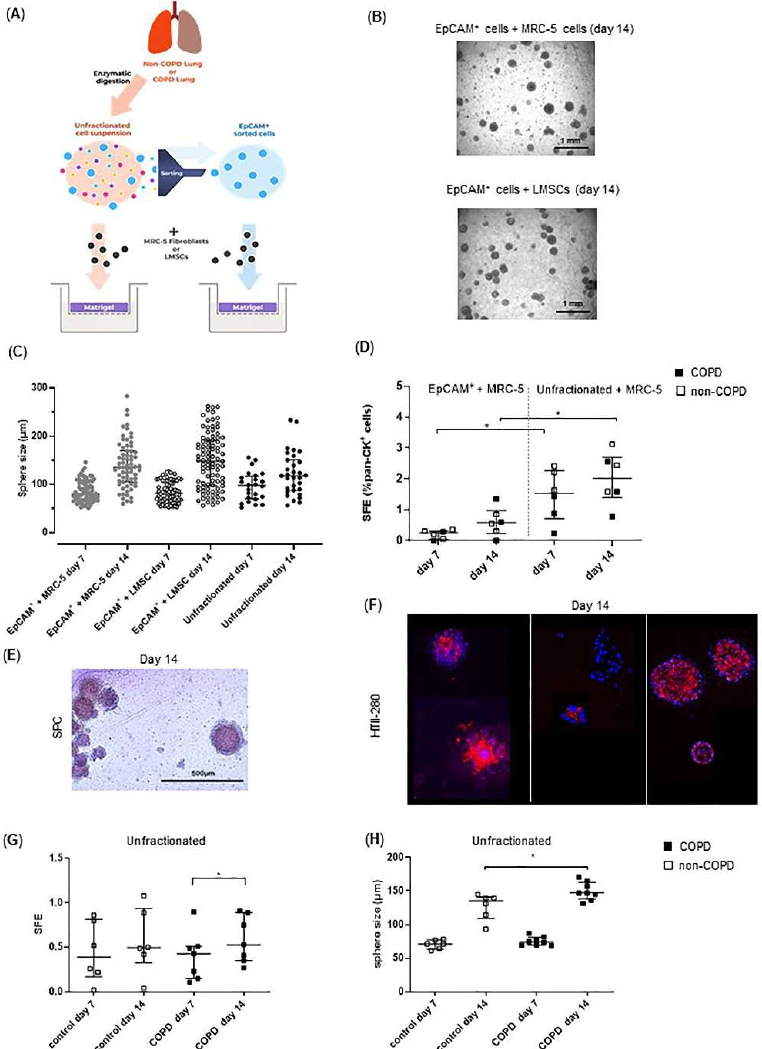
Figure 6. Lung-resident MSCs (LMSCs) support organoid formation by epithelial cells from human distal lungs and organized generated from COPD lung suspensions develop similar abnormalities. Primary human lung cells together with mitomycin- treated MRC-5 cells or mitomycin-treated LMSCs from COPD and control donors were seeded into 100 µL growth factor-re- duced 1:1 diluted Matrigel onto inserts of a transwell and cultured for 7–14 days. The number per well and the size of organoids was measured using light microscopy. ( A ) Schematic picture of the primary lung cell isolation and organoid culture model. ( B ) Representative light microscopic images of organoids generated from EpCAM + progenitors from human lungs generated with MRC-5 or LMSCs support. ( C ) Sphere forming efficiency (SFE) of organoids generated from EpCAM + and unfractionated human lung cell suspensions (from a COPD donor) in absence or presence of MRC-5 cells or LMSCs (pooled fractions from 3 non-COPD donors) at day 7 and day 14. ( D ) Sphere forming efficiency (SFE) of organoids generated from EpCAM + and unfrac- tionated human lung cell suspensions from 3 COPD donors and 3 non-COPD donors at day 7 and day 14. ( E ) Inserts from a COPD donor at day 14 were stained for SPC (using AEC and HE counterstaining). ( F ) Inserts from 3 COPD donors at day 14 were stained for HTII-280 (using Alexa-Fluor 647-labeled antibody and DAPI to visualize nuclei). Representative images are shown. ( G ) Sphere forming efficiency (SFE) and ( H ) mean size of organoids generated from EpCAM + and unfractionated human lung cell suspensions from 8 COPD donors and 6 non-COPD donors in presence of MRC-5 cells at day 7 and day 14. * = p < 0.05 between the indicated values as analyzed by the Mann–Whitney U